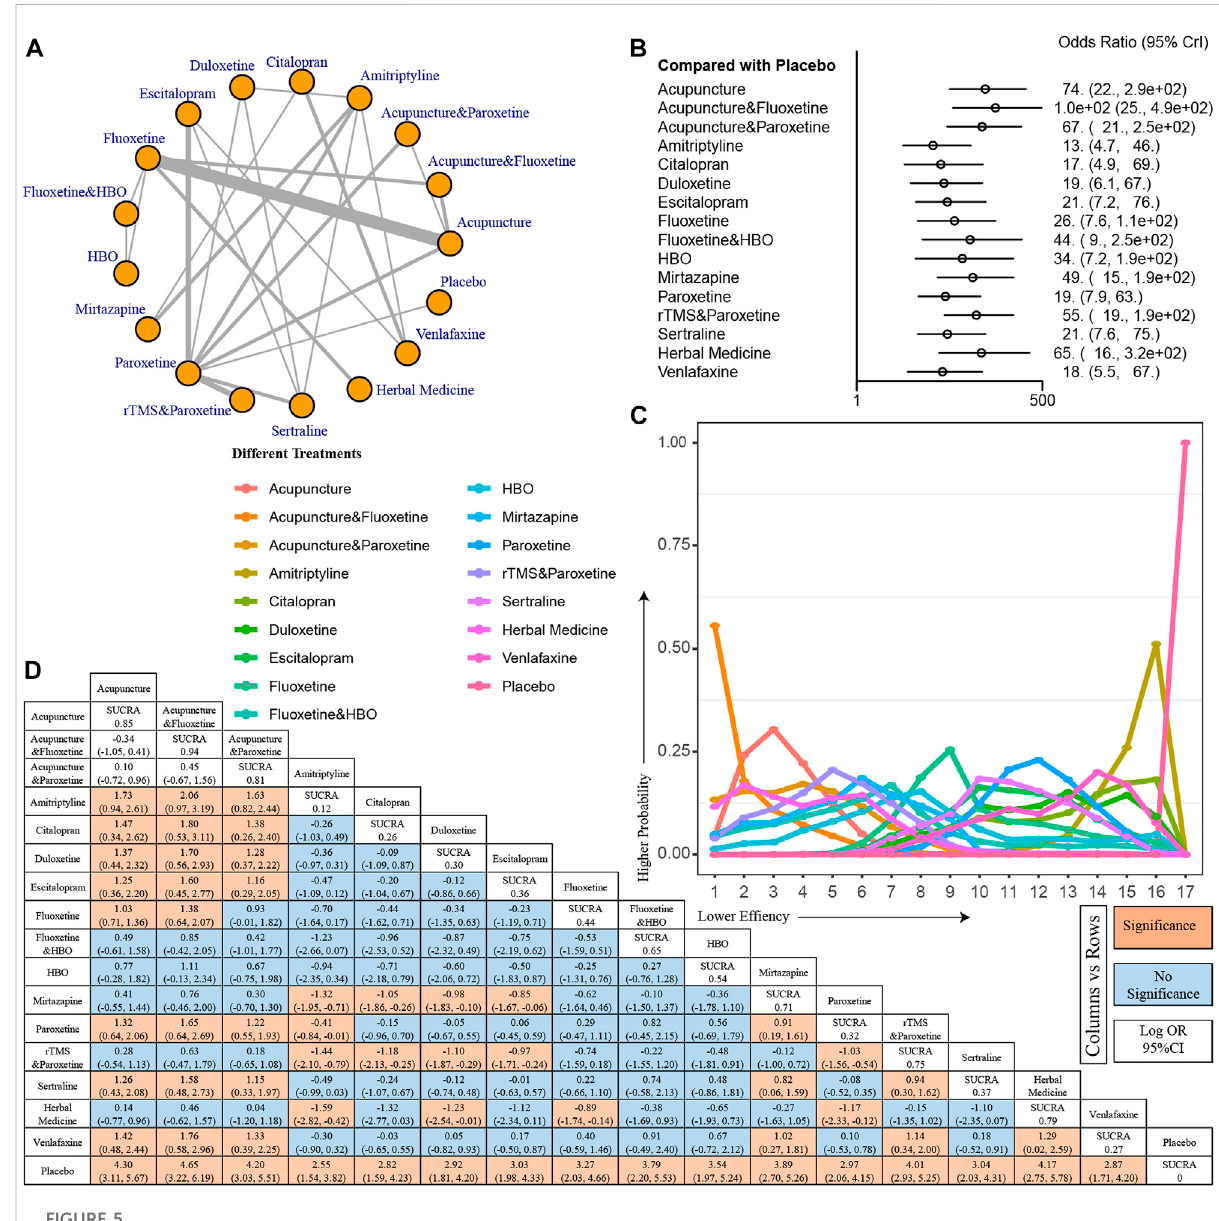
IPercentageofpatientswith50%improvementinHAMD. (A) Networkmodel. (B) Forestplotforcomparisonsbetweentreatmentsandplacebo. (C) Line graph for probability ranks. (D) League